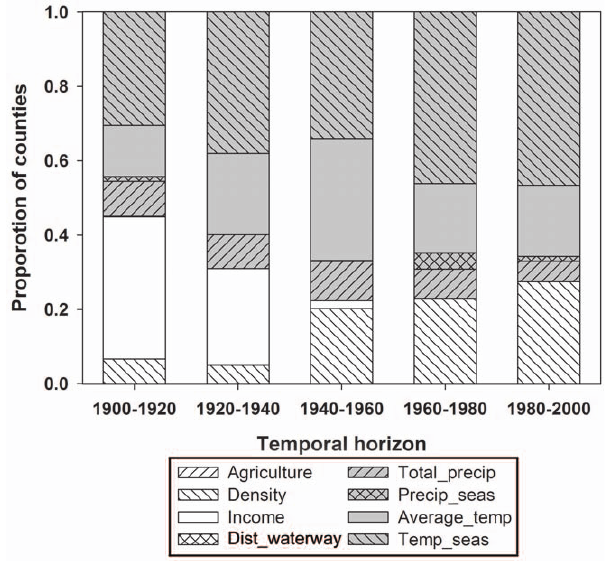
Figure 5. Relative importance of climatic and non climatic variables in GWR models predicting demographic growth rates. Climatic variables are shown in grey and non-climatic variables in white. The relative importance of each variable is based on the proportion of counties where its standardized regression coefficient (std b ) was highest in absolute value (see Fig. 6).